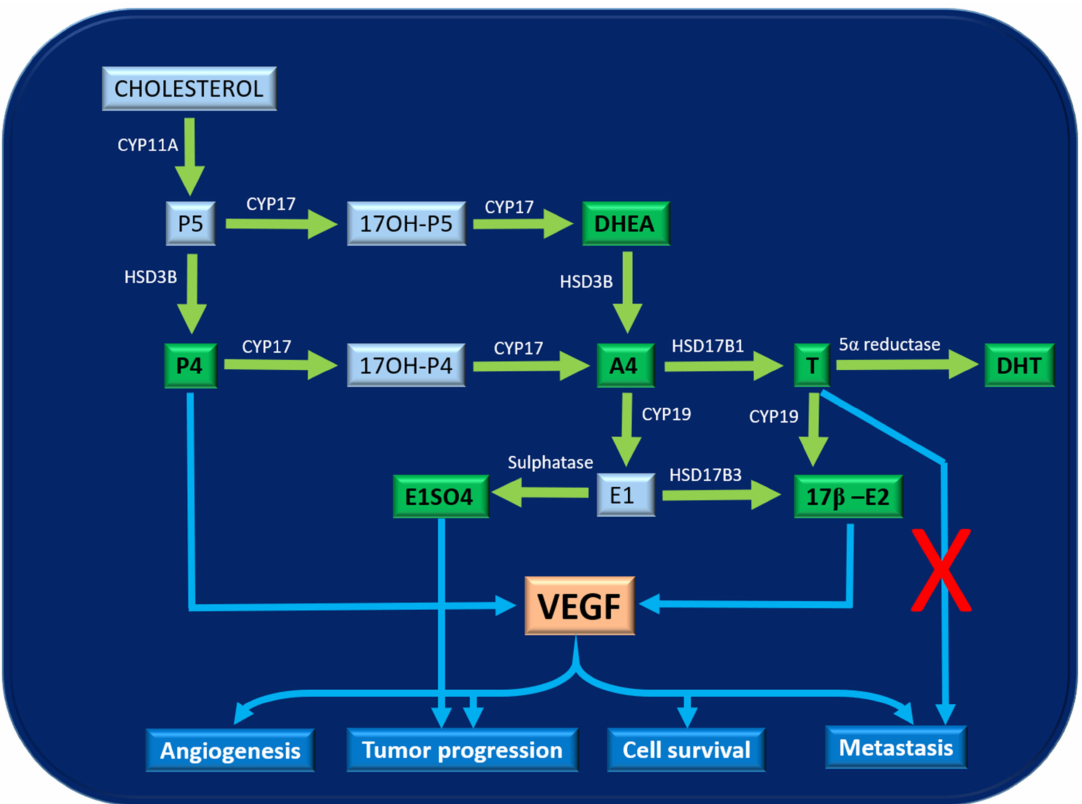
Figure 9. Scheme of the steroidogenic cascade. Hormones within the green box are the ones measured in this study. It can be observed that P4 and E2 induce the production of VEGF which will promote the processes of angiogenesis, tumour progression, cell survival and metastasis. Likewise, elevated E1SO4 can also promote tumour progression itself. However, an increase in T could be to be related to a lower risk of